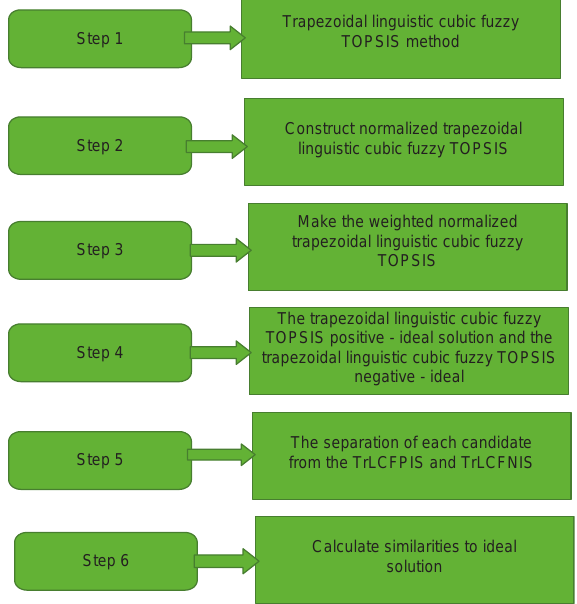
Figure 1: Flow Chart of the Extended Trapezoidal Linguistic Cubic Fuzzy TOPSIS Method.